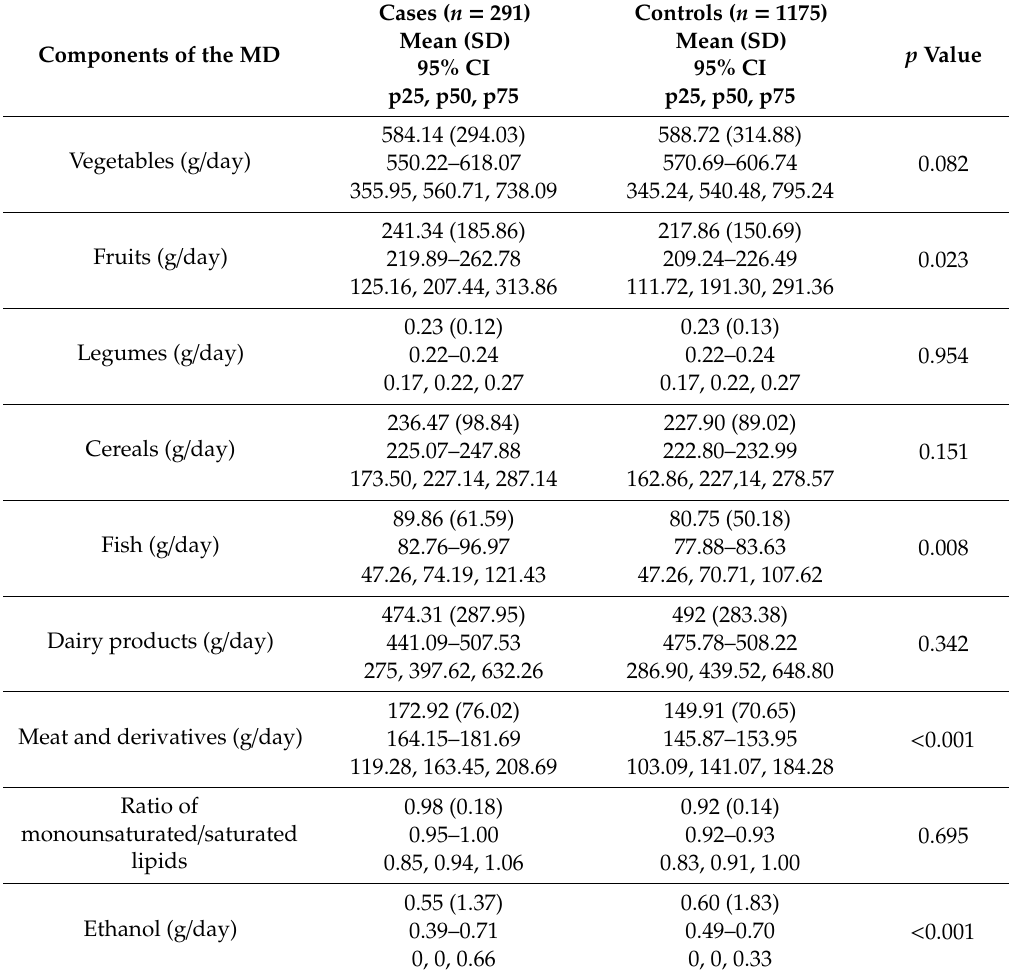
Table 2. Consumption of the components of the Mediterranean diet in the cases with gestational diabetes mellitus and the controls without gestational diabetes mellitus.